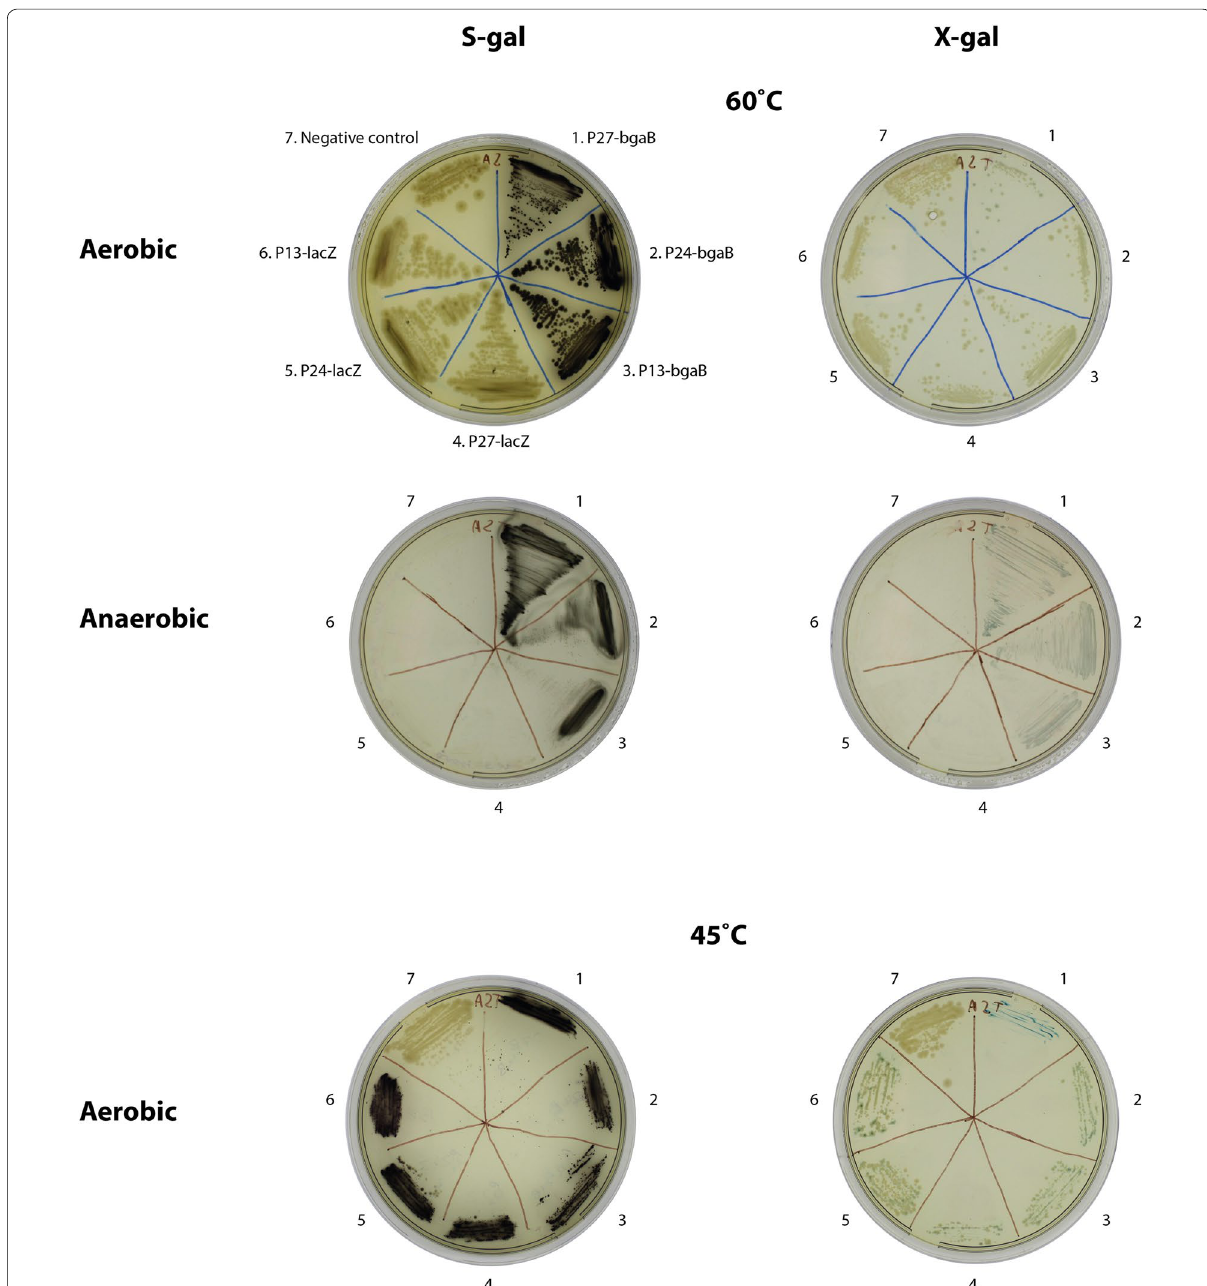
Fig. 3 Expression of bgaB and lacZ in G. thermoglucosidans at 60 and 45 °C under aerobic and anaerobic conditions. The plates were supplemented with either S-gal or X-gal. Promoters P13, P24, and P27 of different strength were taken from the library (see Fig.